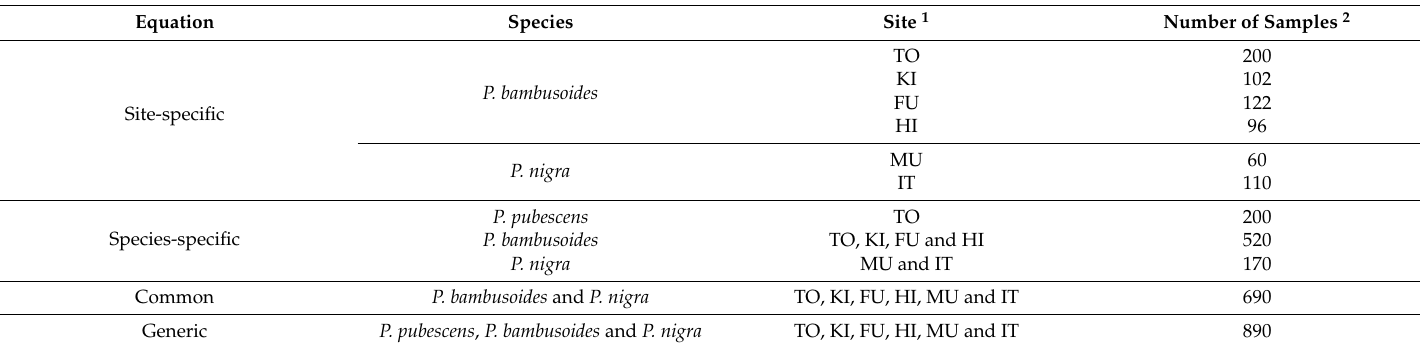
Table 2. Explanation of the allometric equations developed in this